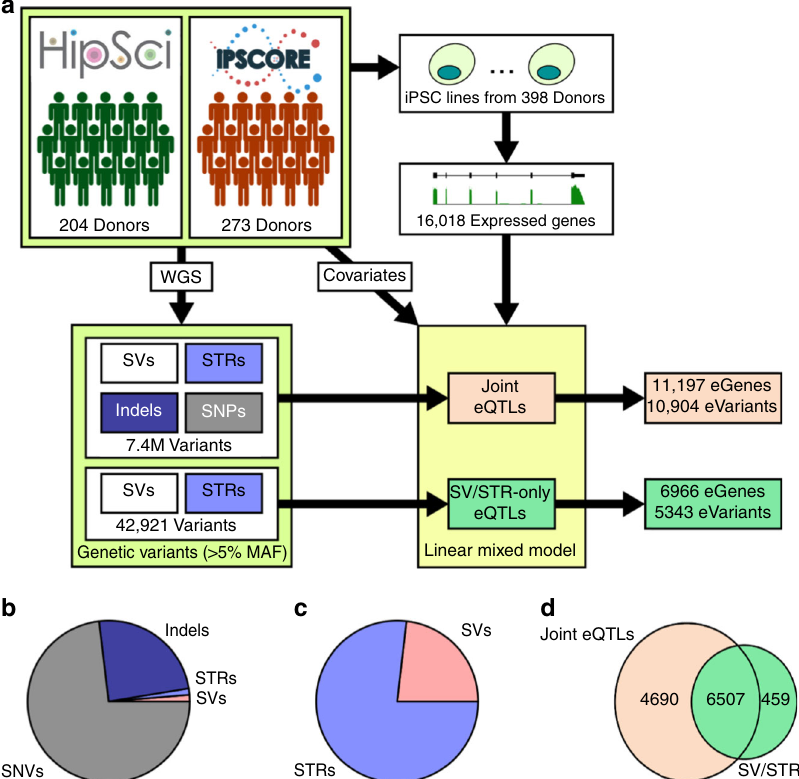
Fig. 1 eQTL mapping. a Overview of eQTL study design. We performed two eQTL analyses: a joint analysis that used all variants and identi fi ed 11,197 eGenes and an SV/STR-only analysis that only used SVs and STRs and identi fi ed 6,996 eGenes. b , c Pie charts showing the number of lead variants across the different variant classes for ( b ) joint and ( c ) SV/STR-only eQTL analyses. d Venn diagram showing the intersection between the eGenes detected in the joint and the SV/STR-only analysis. Table 1 Summary of i2QTL variants and eQTL results. Variant